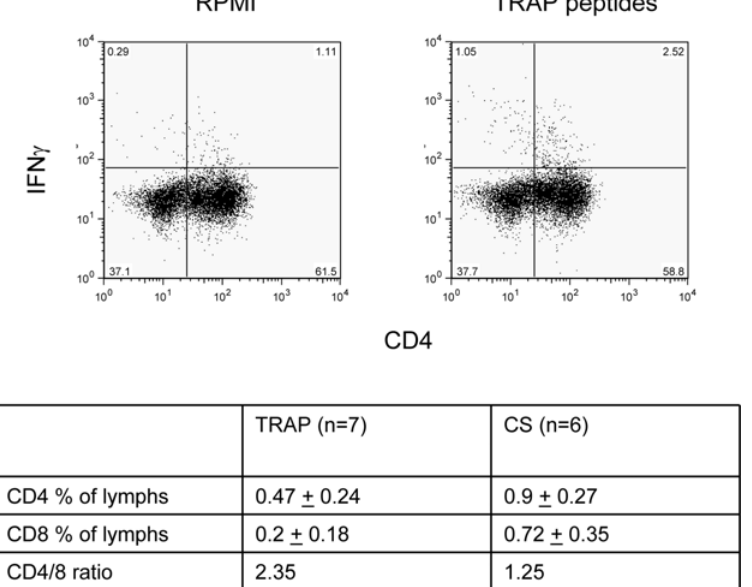
Figure 3. Intracellular IFN c Staining following culture. ICS for IFN c was carried out on cells by restimulation with peptides, following 10 days of culture, and co-staining with CD4 or CD8. The mean percentages ( 6 standard deviation) of IFN c + cells possessing CD4 or CD8 (with medium controls subtracted) are shown together with the mean CD4:CD8 ratio.